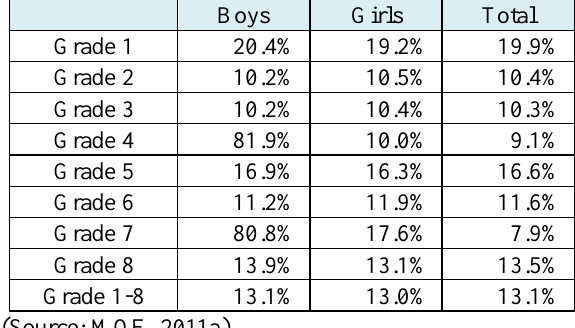
Table 4-7: Primary Dropout Rates by Grade and Gender (2010/11) (%) Boys Girls Total Grade 1 20.4% 19.2% 19.9% Grade 2 10.2% 10.5% 10.4% Grade 3 10.2% 10.4% 10.3% Grade 4 81.9% 10.0% 9.1% Grade 5 16.9% 16.3% 16.6% Grade 6 11.2% 11.6% Grade 7 80.8% Grade 8 13.9% 13.1% 13.5% Grade 1-8 13.1% 13.0% 13.1% (Source: MOE,